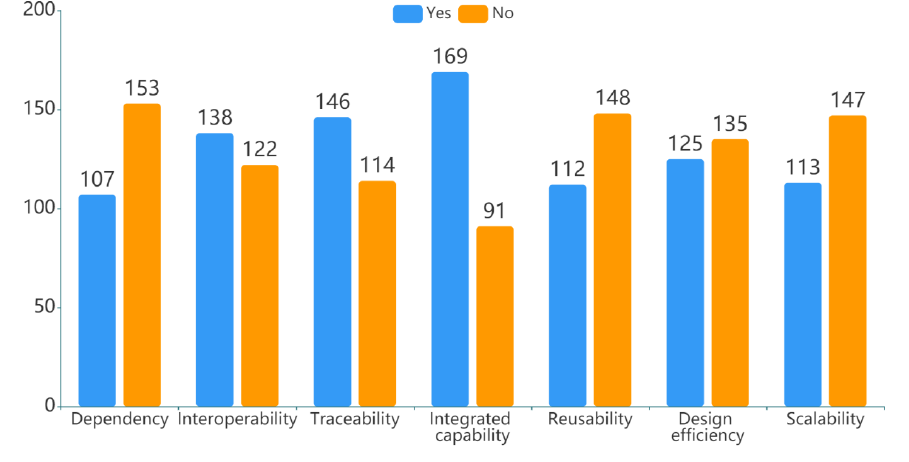
Figure 17. Measurements of MBSE tool-chains in the studies.